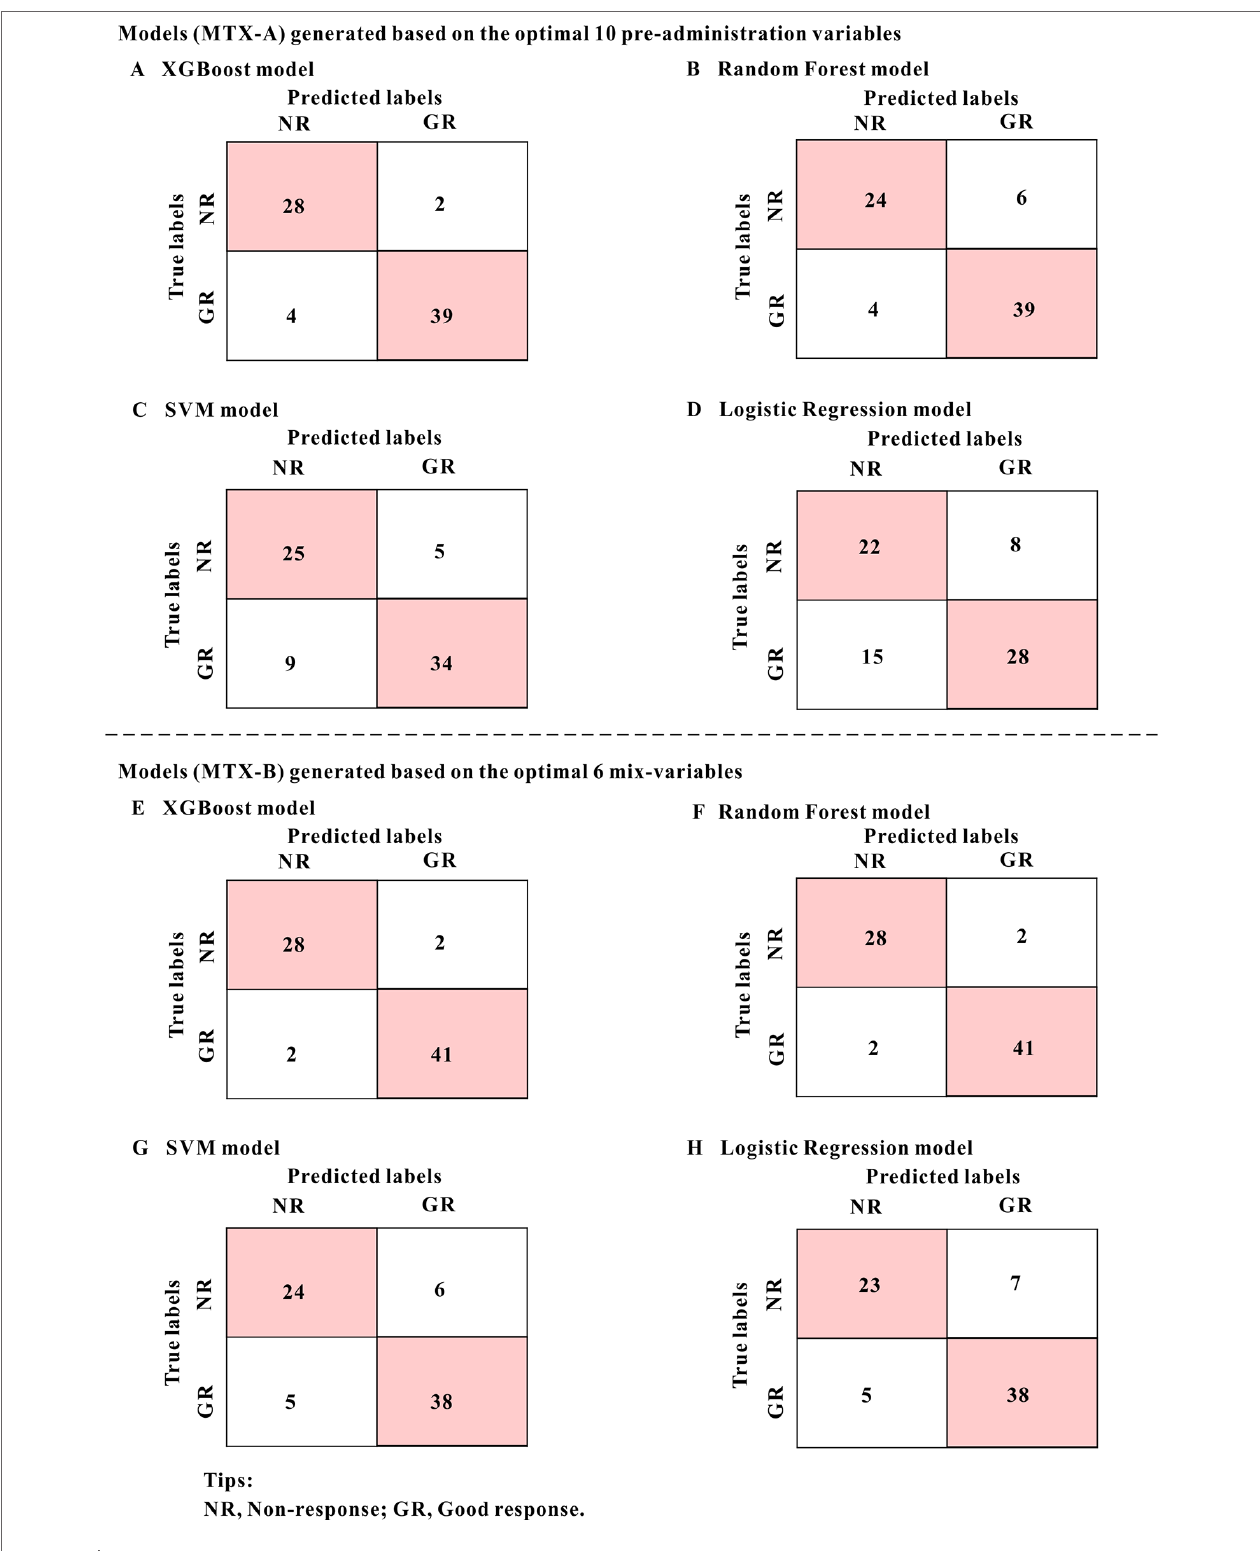
FIGURE 4 | The mixed matrix results of each model in the MTX-A and MTX-B predictors of the test set. For example, when the true lables were NR(non-response) and predicted lables were NR, it indicated that the number of NR was correctly predicted. However, when true lables were NR, and predicted labels were GR (good response), it indicated the number of NR incorrectly predicted to GR. As can be seen from the figure, the predicted values of model A (XGBoost model) and model E (XGBoost model) are the closest to the real values, indicating the best prediction performance. The numbers in the pink grids represent the number of cases that were accurately